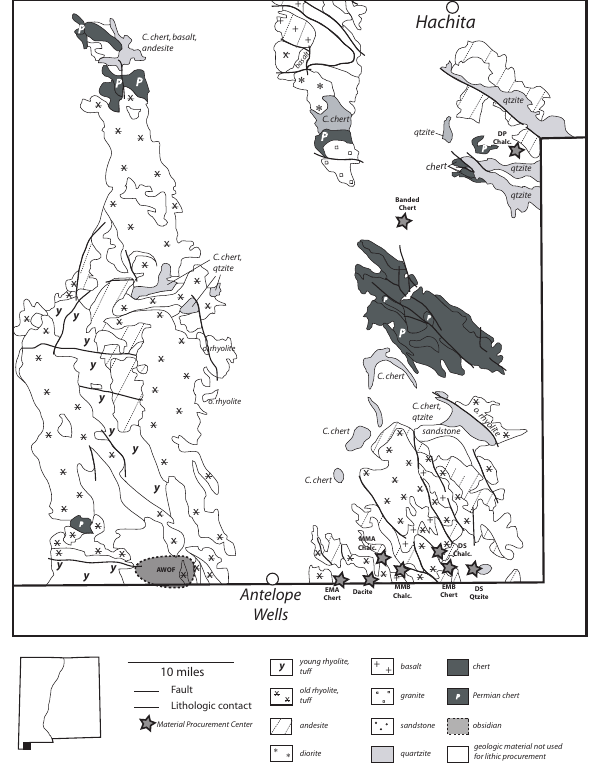
Fig. 3. Locations of lithic procurement sites (“quarries”) in the southwestern New Mexico with detailed